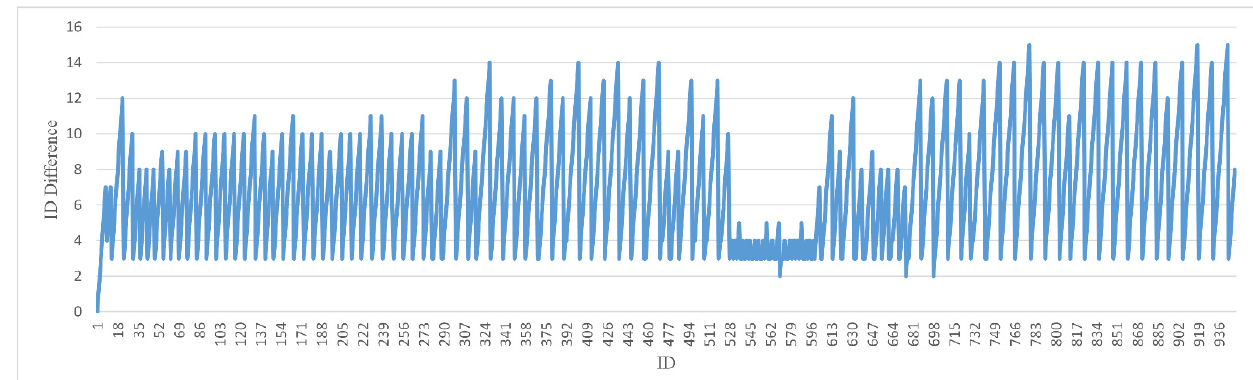
Figure 12. The difference between the nearest keyframe ID and the current frame ID.